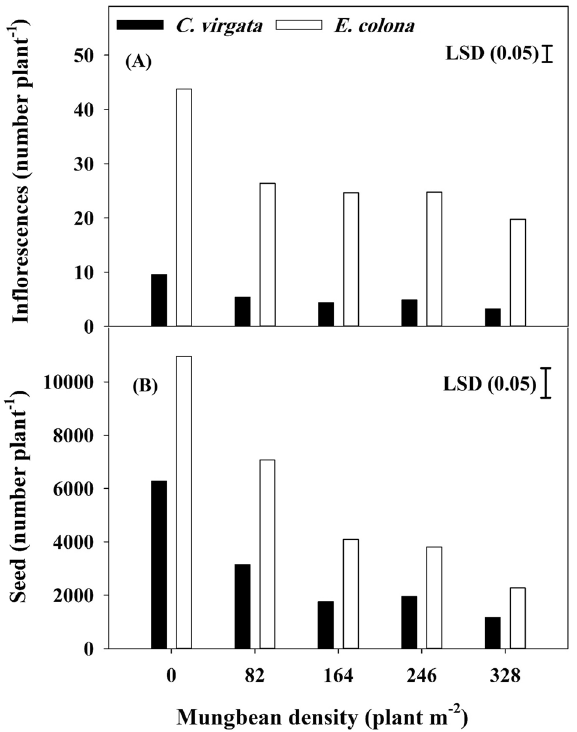
Figure 2. ( A ) Inflorescence number per plant and ( B ) Seed production per plant of C. virgata and E. colona when grown alone (0 MB) or in competition with 82, 164, 246 and 328 mungbean (MB) plants. Capped bar denotes LSD values at p ≤